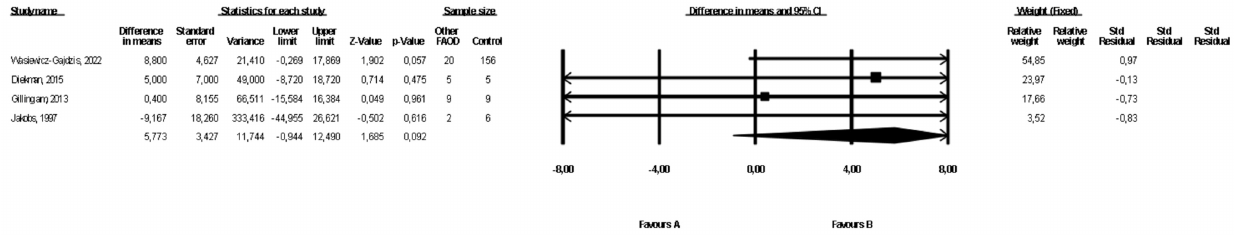
Figure 6. Forest plot—comparison of body weight in patients with FAOD other than MCAD vs. controls [16,18,22].